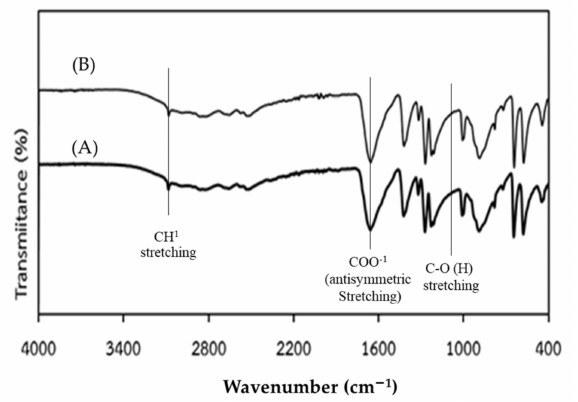
Figure 3. FTIR spectra of (A) commercial fumaric acid (FA) and (B) biosynthesized FA measured in the range of 4000–400 cm − 1 with a resolution of 4 cm − 1 and 32 scans.